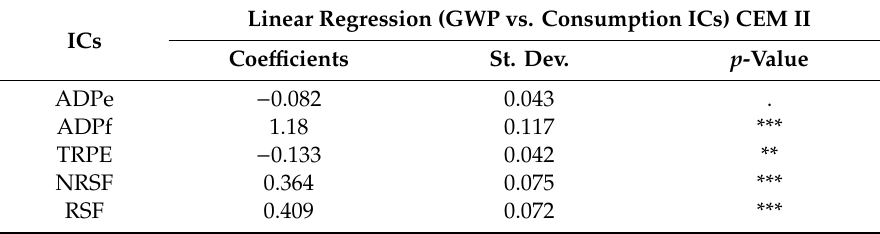
Table 13. AIC selection model (GWP vs. Consumption ICs)—CEM II.